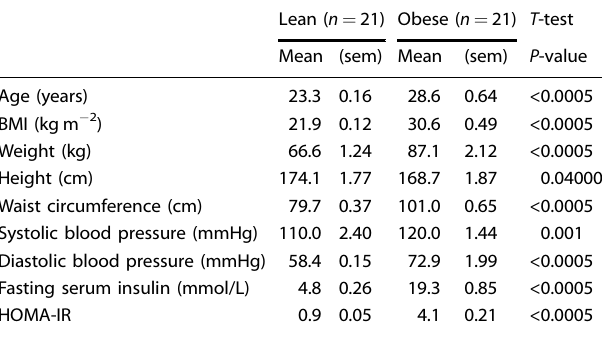
clinical utilities of this technique to rapidly sub-stratify diabetes subjects based on their oxidative status in conjunction with their standard glycemic level. Through the use of the proposed methodology, we learnt new biological insights to the disease mechanism of DM, and discussed how sub-strati fi cation of oxidative status may facilitate the early detection (or warning) of diabetes complications (e.g., cardiovascular event). We hope that